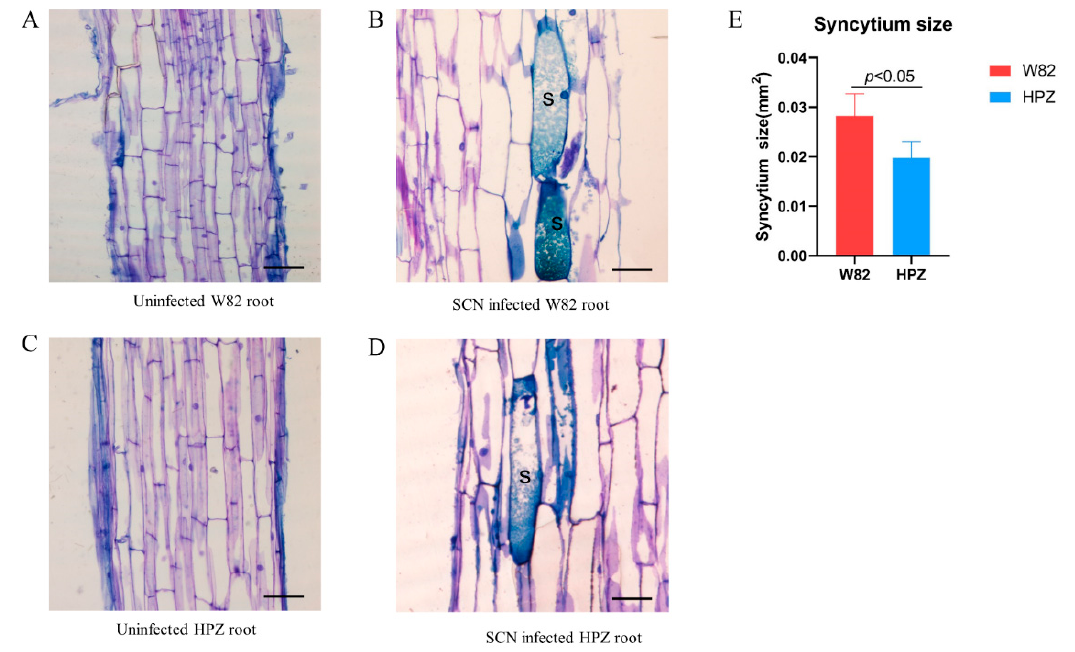
Figure 2. Histological observation of syncytium size in HPZ and W82 at 5 dpi. ( A ) uninfected W82 root, bar = 100 µ m, ( B ) SCN-infected W82 root, the syncytium induced by SCN was labeled with “S”, bar = 50 µ m, ( C ) uninfected HPZ root, bar = 100 µ m, ( D ) SCN-infected HPZ root, the syncytium induced by SCN was labeled with “S”, bar = 50 µ m, ( E ) average size of syncytium in W82 and HPZ values are the mean syncytium size, bar, standard error. Pictures of syncytia were taken by an OLYMPUS DP80 light microscope (Olympus, Japan), and the size of the syncytia was measured with Cellsens standard software. Syncytium size data were checked for normality with the Kolmogorov–Smirnov or Shapiro–Wilk test, then the t-test method was used to analyze these above data with SPSS software. Size values of the five syncytia were used for t-test, p < 0.05 means a significant di ff erence was found between W82 and